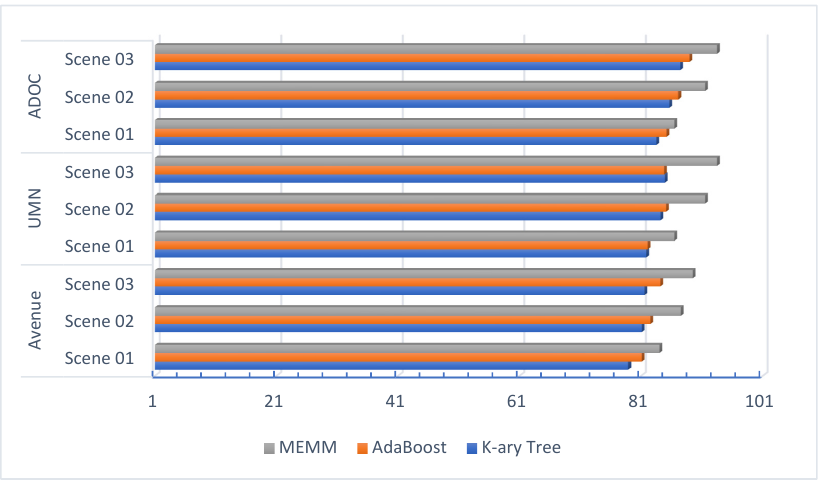
Figure 12. Comparison of MEMM with Adaboost and K-ary Tree hashing algorithms.